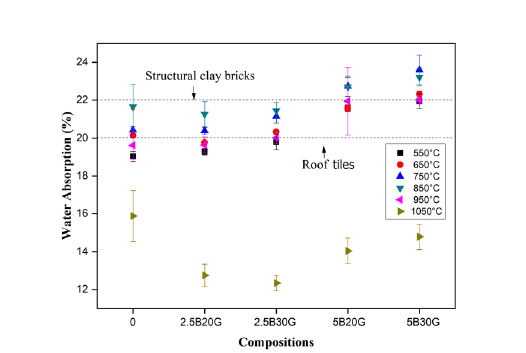
Figure 5. Dry apparent density of compositions.